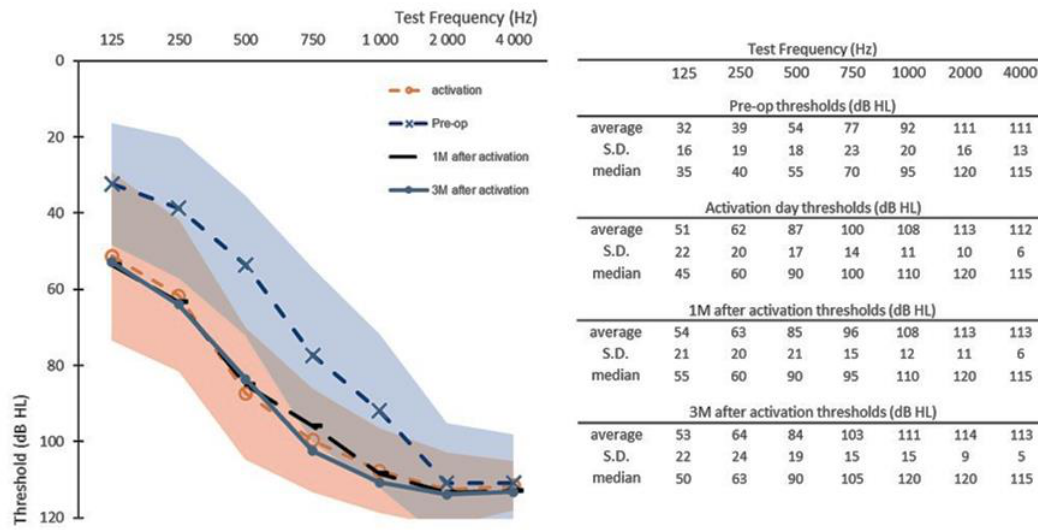
Figure 1. Pre-operative hearing thresholds (Pre-op, n = 15), post-operative hearing thresholds at activation day (activation, n = 15), at one month after activation (1M, n = 15) and at three months after activation. (3M, n = 14). Shaded areas represent the maximal and minimal standard deviations of the pre-operative data (in blue) and of the activation day data (in orange). S.D. = standard deviation .